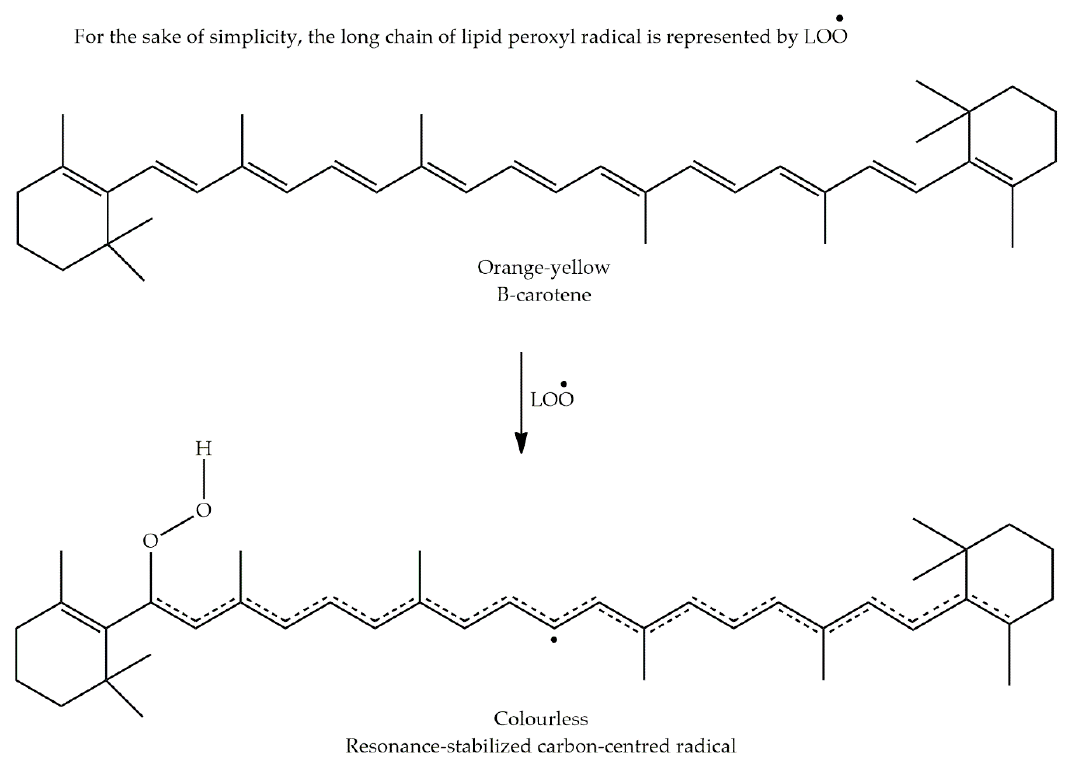
Figure 18. β -carotene reaction mechanism.